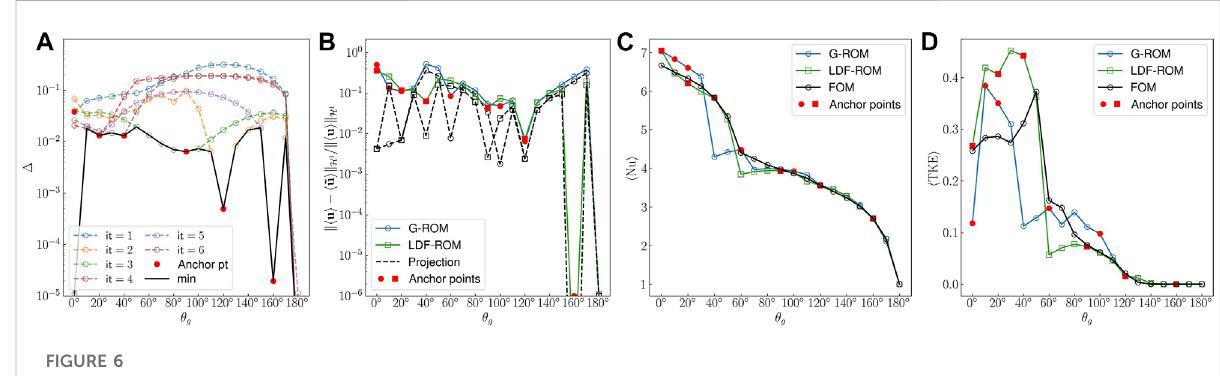
FIGURE 6 POD- h GreedyperformancecomparisonbetweenG-ROMandLDFROMfortheparametric problemparameterizedwith θ g ∈ [60 ° ,180 ° ]atRa= 3 × 10 5 and Pr = 7.2. (A) Behavior of the error indicator Δ de fi ned in Eq. 44 for fi ve iterations with LDF-ROM. (B – D) Behavior of the relative H 1 error in predicted solution, meanNuand meanTKEwith θ g basedon fi veanchorpoints.( N =80at θ g =10 ° ,20 ° ,40 ° ,60 ° ,90 ° ,100 ° , N =70at θ g =0 ° , N =50at θ θ g = 120 ° and N = 1 at g = 160 °